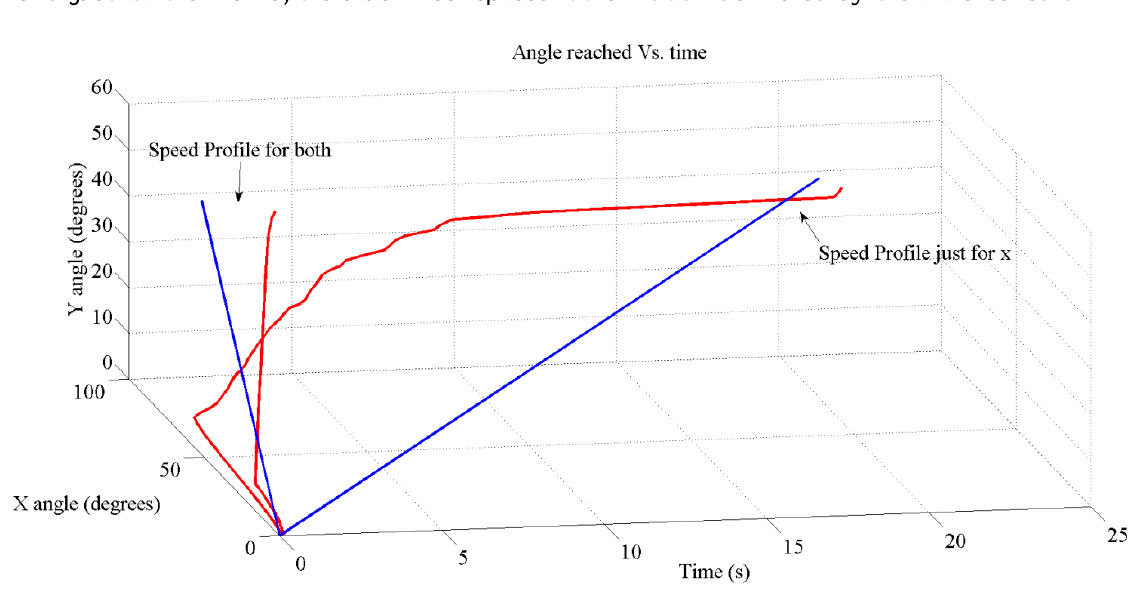
Figure 17. Angle vs . time reached for both axis with (125, 90) input. The retina has 128 × 128 pixels. The communication between neural boards was made by AER. The red lines show the trajectory followed by the robot when we used the speed profile for both axis and just for the x-axis; the blue lines represent the motion delivered by the DVS sensor.